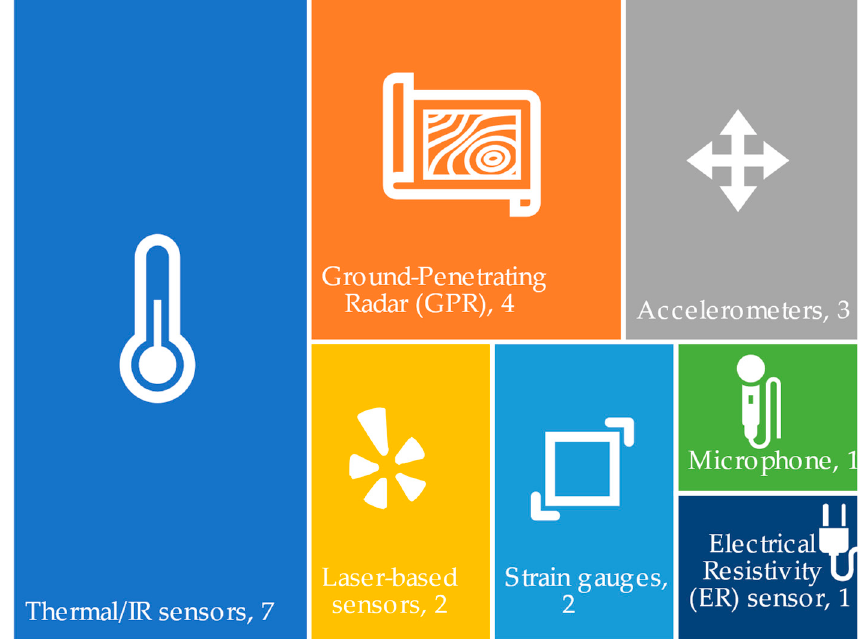
Figure 5. Types of sensing technologies used with robots for inspection and monitoring.